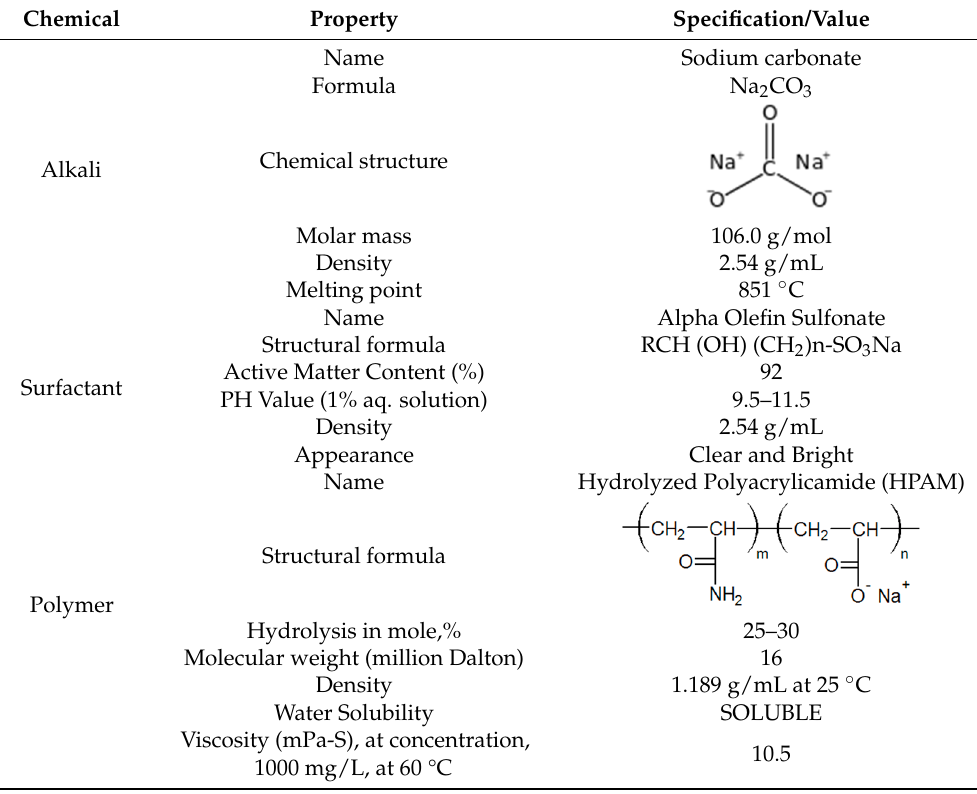
Table 5. Properties of the alkali/surfactant/polymer used in the emulsion study.